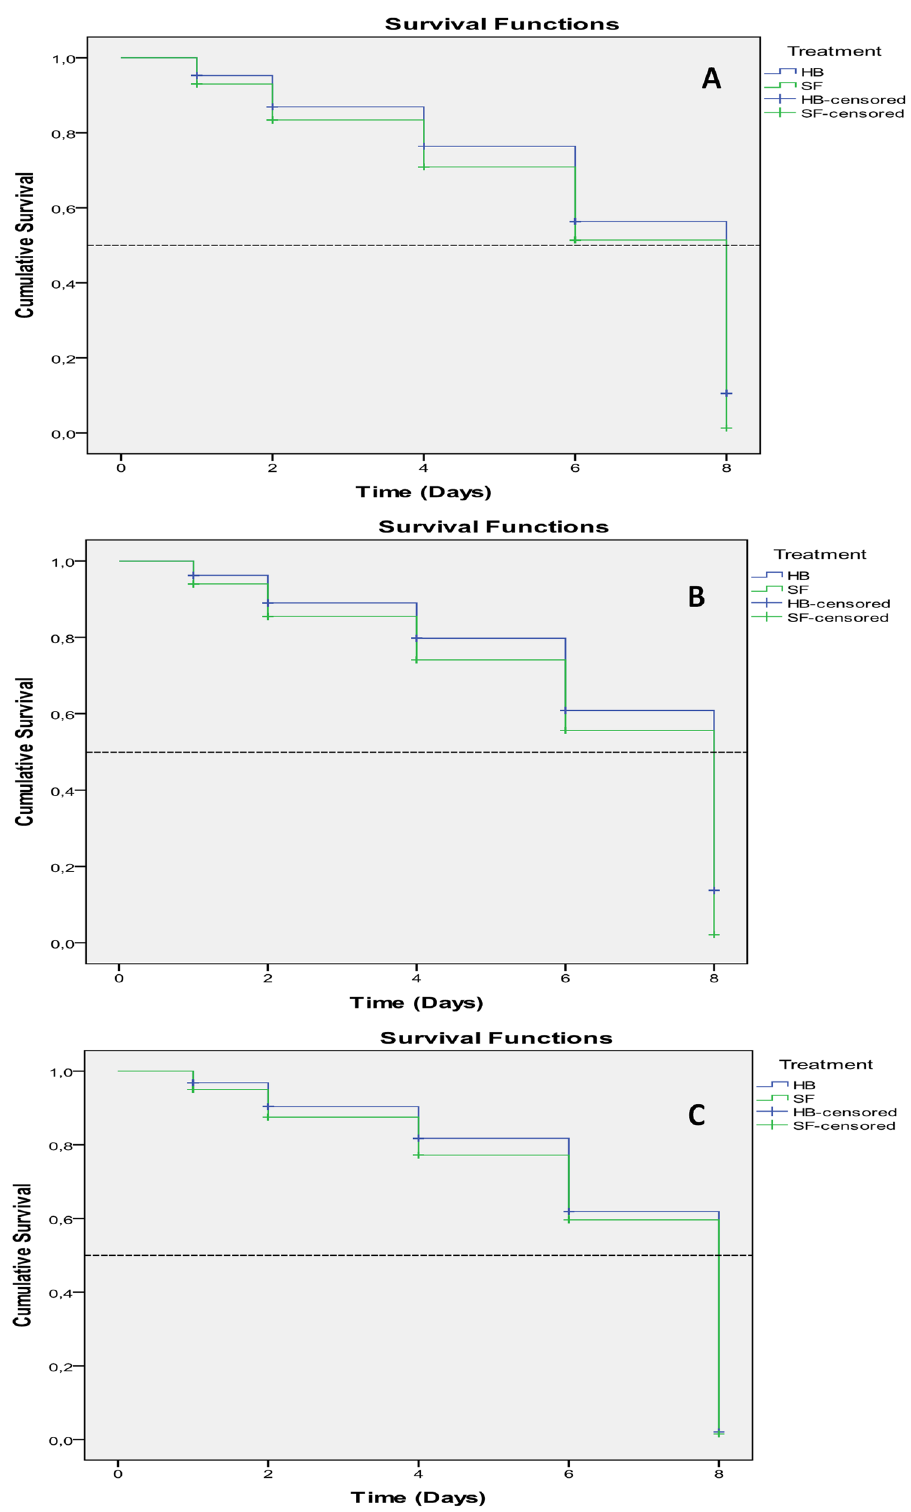
Figure 8. Survival curves (Lethal time LD 50 ) of Dactylopius opuntiae adults female treated by different concentrations of the two EPNs: ( A ) 75 IJs cm −2 , ( B ) 50 IJs cm −2 , ( C ) 25 IJs cm −2